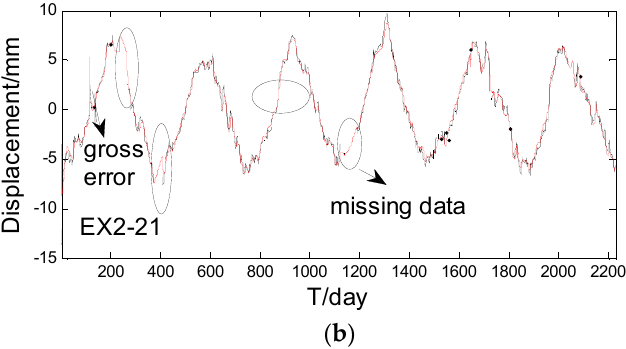
Figure 6. Filter and interpolated missing data results. ( a ) Filter and interpolated missing data results of all points; ( b ) Filter and interpolated missing data results of EX2_21.